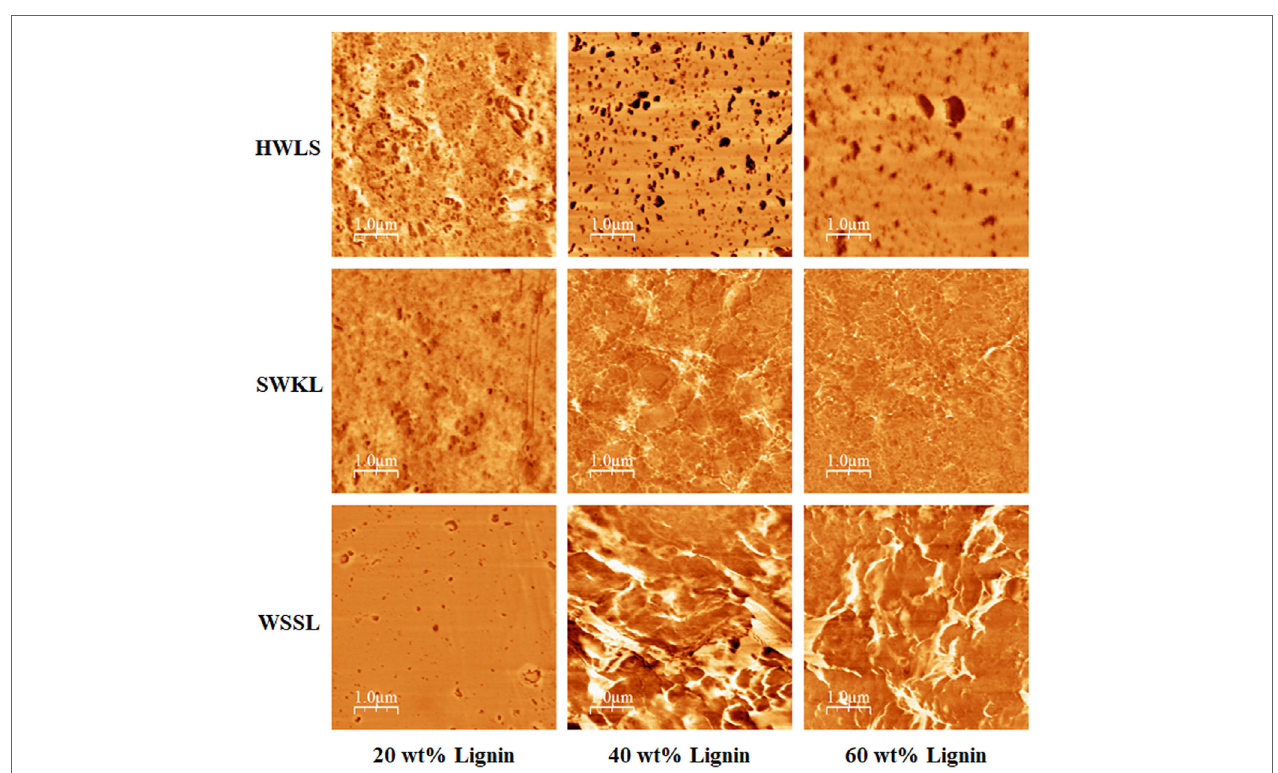
FigUre 9 | Atomic force microscope phase images of lignin-based polyurethane samples at 20, 40, and 60 wt% lignin